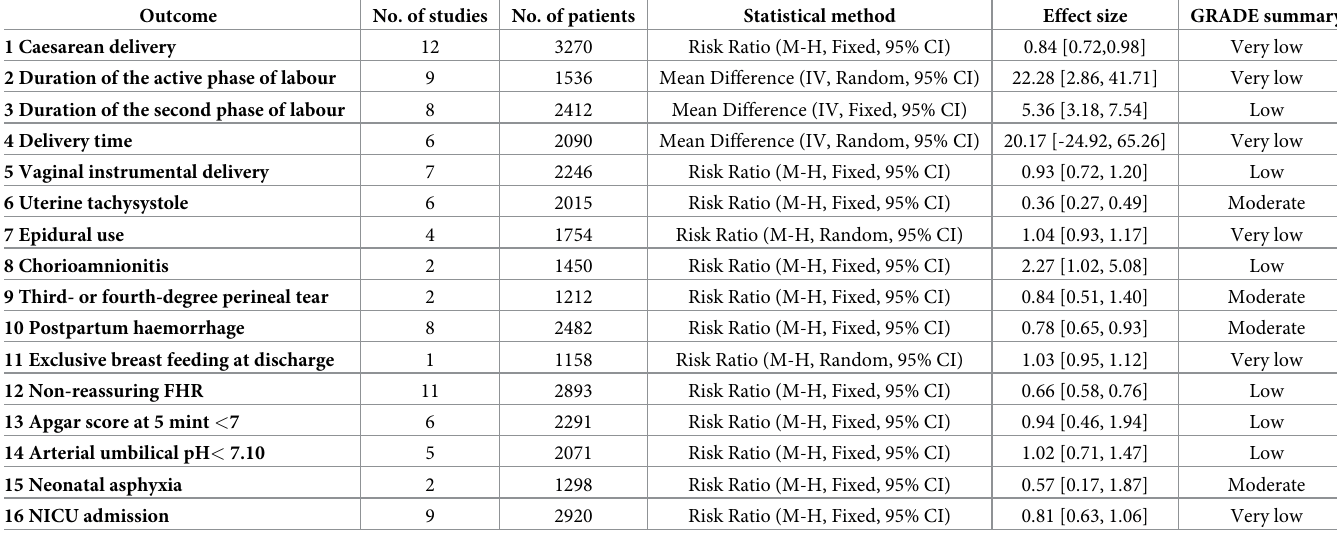
Table 6. Pooled outcomes for this meta-analysis.